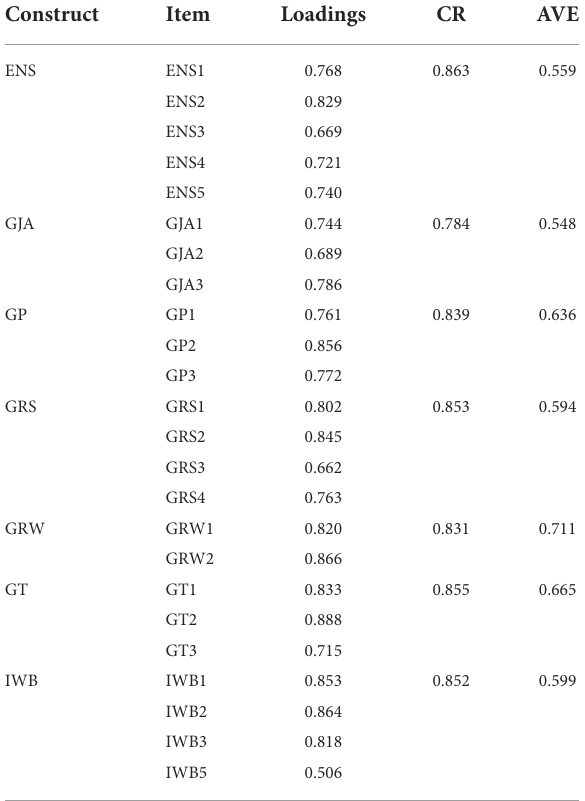
TABLE 1 Measurement